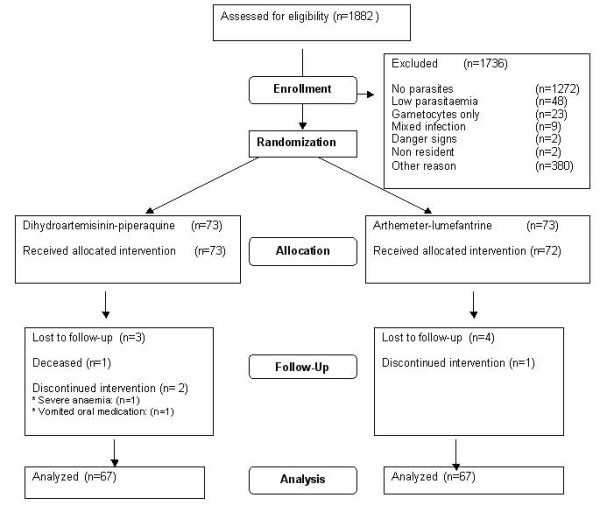
Schematic representation and flowchart of the study.